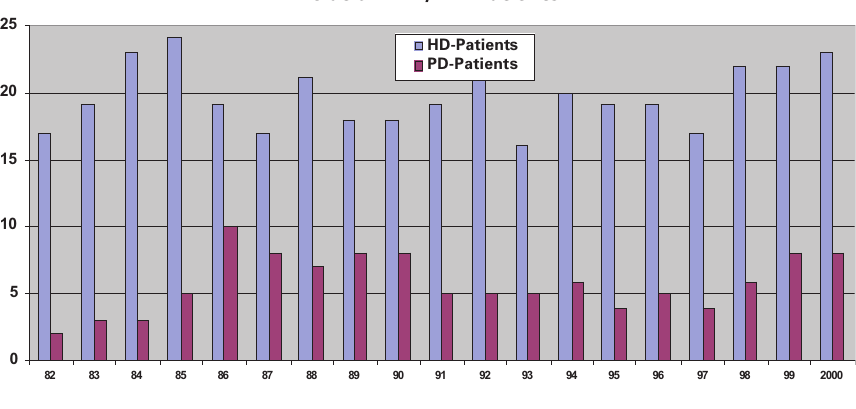
Figure 2 Kaplan-Meier esti- mates, for overall mortality on peri- toneal dialysis (PD) with death on PD as final event (green curve) and technique retention rate with death, transfer to haemodialysis and transfer to transplan- tation as final events (blue curve).